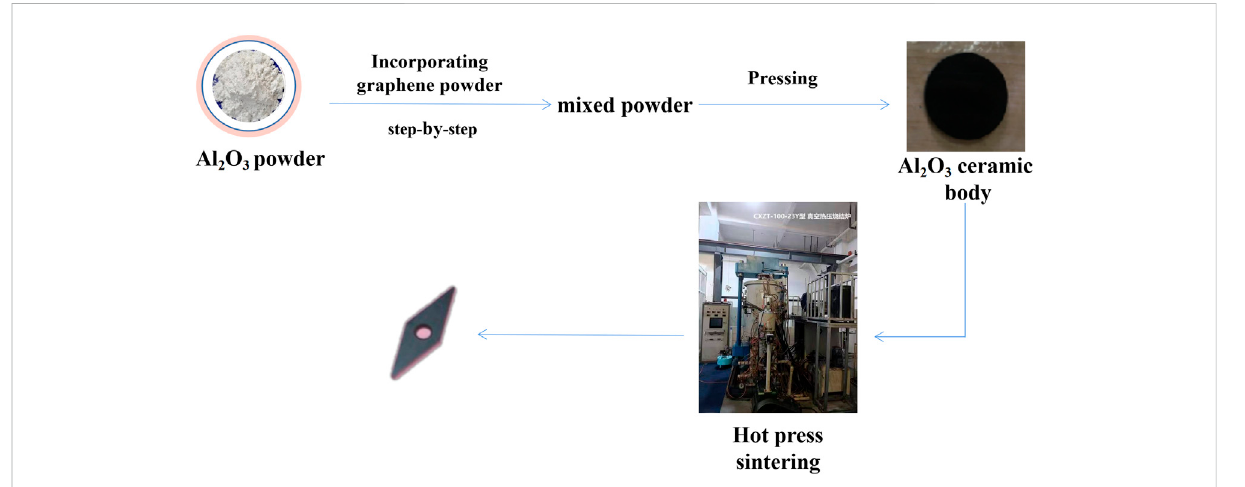
FIGURE 1 The schematic of preparation process of Al 2 O 3 -G